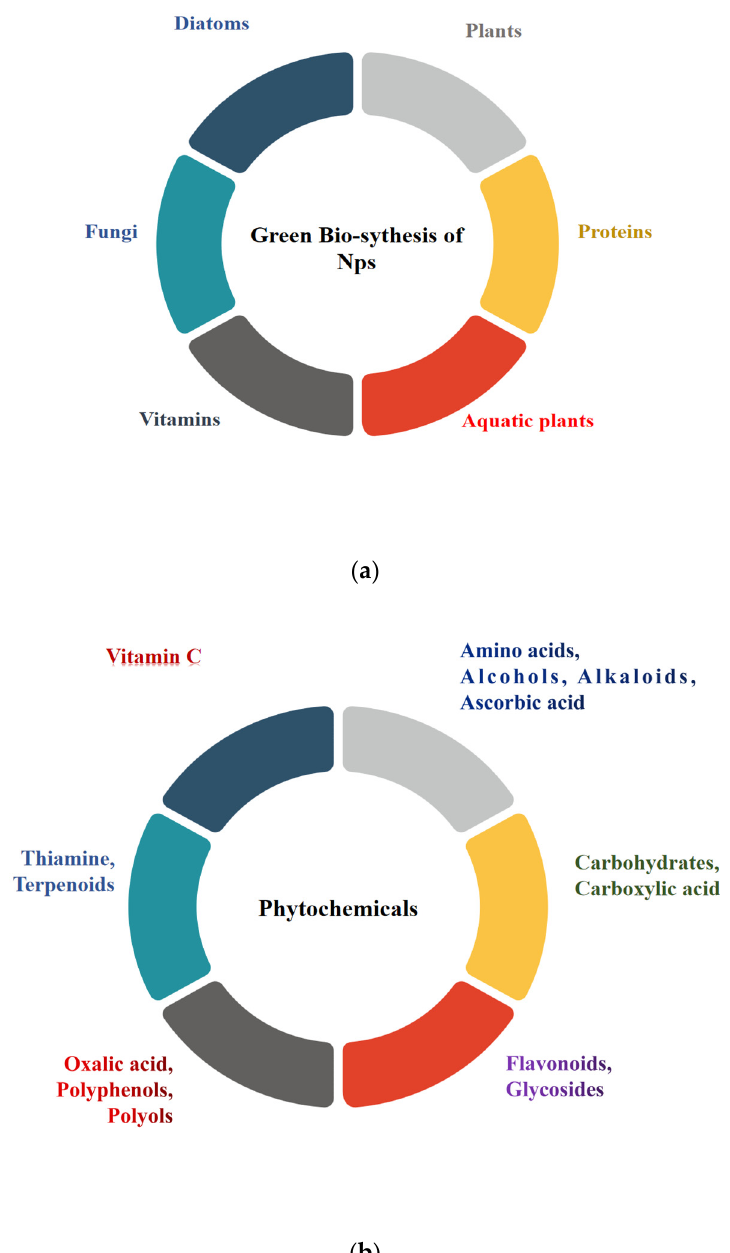
Figure 4. Several natural resources for synthesizing green NPs ( a ) and a few important bio- reductants found in plant extracts ( b